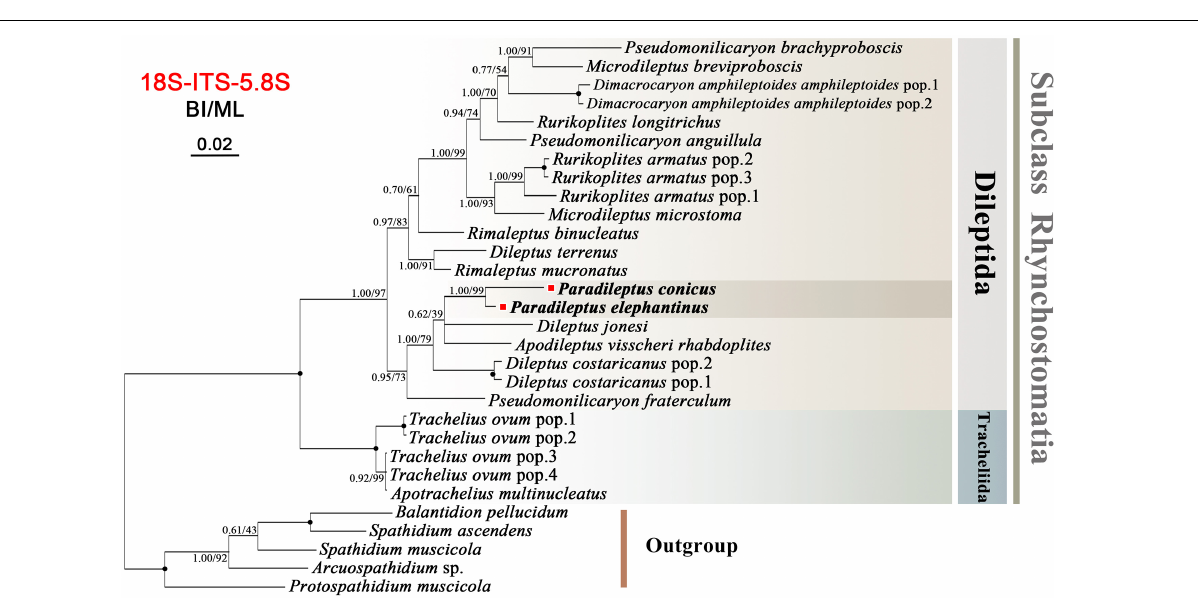
FIGURE 8 | Bayesian inference (BI) tree inferred from concatenated rDNA (concatenated with 18S rDNA and ITS1-5.8S-ITS2) sequences focusing on the subclass Rhynchostomatia (25 rhynchostomatian and five spathiid taxa). Numbers near branches show the posterior probabilities from BI and bootstrap values from maximum likelihood (ML) analyses. Fully supported (1.00/100) branches are marked with solid circles. The scale bar corresponds to 5 substitutions per 100 nucleotide